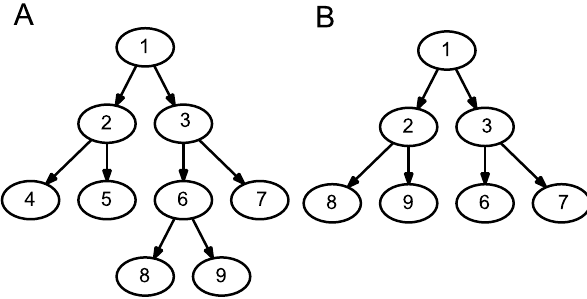
Figure 3. Example simulated and inferred trees illustrating key terms in the formula for calculating the reconstruction error. (A) A hypothetical simulated ground truth tree on the set of taxa f 1,2,3,4,5,6,7,8,9 g . (B) Example inferred tree built on the sampled set of taxa f 1,2,3,6,7,8,9 g on the dataset resulting from the ground truth tree.